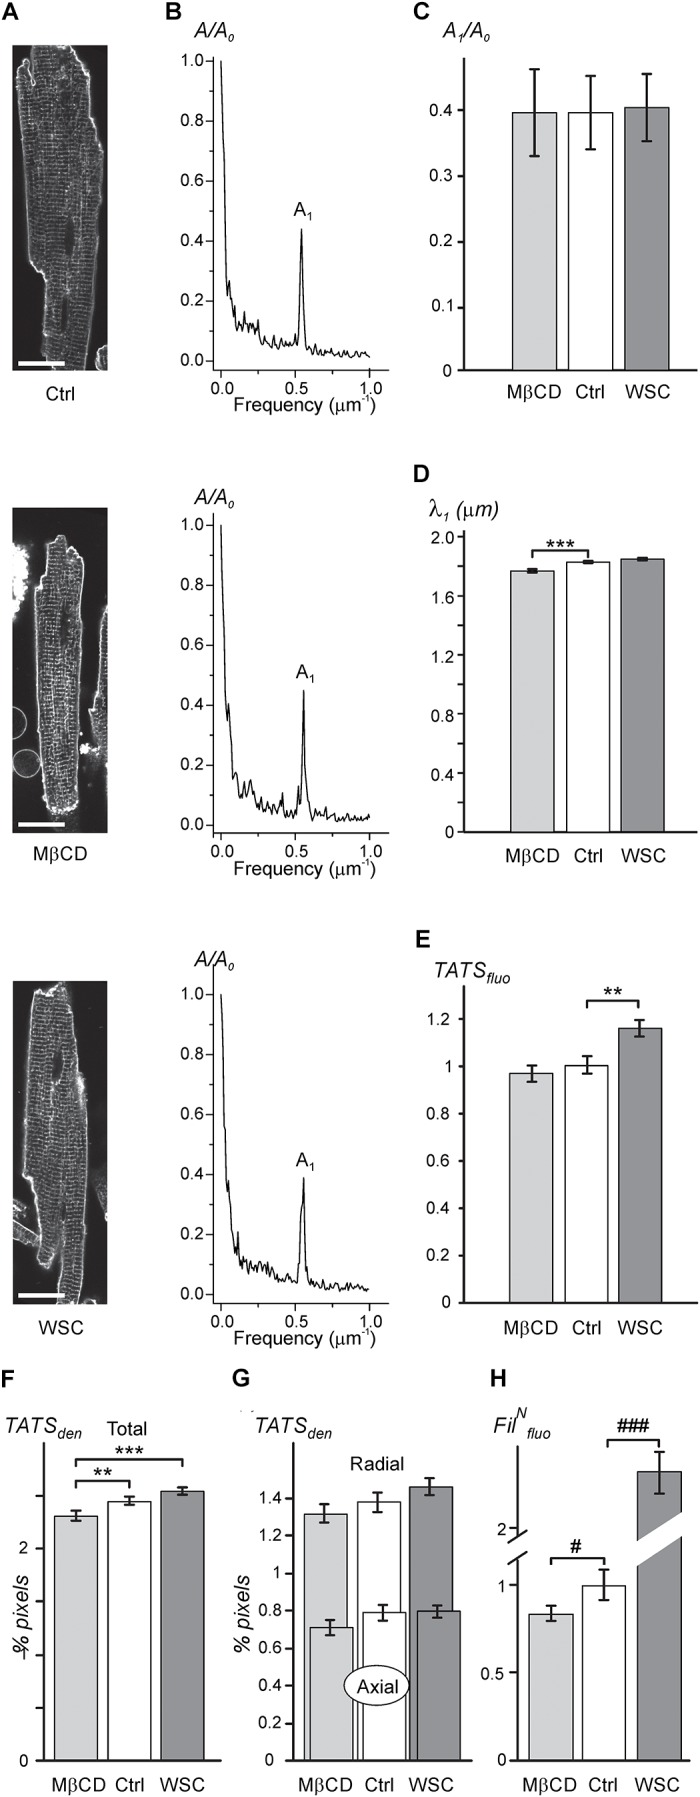
Effects of MβCD and WSC on TATS appearance (A; left column). Representative confocal images of control (Ctrl), 3 mM MβCD- and 5 mg/mL WSC-treated ventricular myocytes stained with di-8-ANEPPS. Scale bars: 20 μm. (B; middle column). Corresponding amplitude spectra of fluorescence (normalized to the amplitude of zero order component (A0). (C) Normalized amplitude (A1) and (D) wavelength (λ1) of the first harmonic of fluorescence. (E) Density of t-tubular fluorescence (TATSfluo) normalized to that in Ctrl myocytes. (F,G) Densities of various components of TATS derived from skeletonization of confocal images of cardiomyocytes labeled with di-8-ANEPPS. The density is calculated as percentage of pixels belonging to TATS skeleton. n = 20, 20, and 20 for Ctrl, MβCD- and WSC-treated cells, respectively. (H) Effects of MβCD and WSC on the intensity of filipin (cholesterol specific agent) staining. The data are normalized to that obtained in control cardiomyocytes. n = 67, 44 and 59 for Ctrl, MβCD- and WSC-treated cells, respectively.)